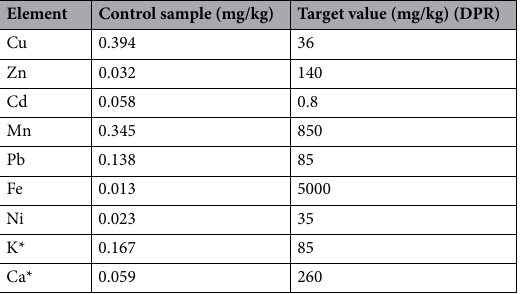
Table 4. Comparison of the control sample values with the standard permissible limits. *IUGS/IAGC Standard permissible